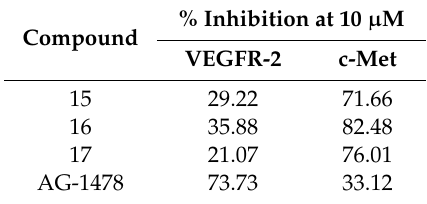
Table 6. Inhibition percent of compounds 15 , 16 and 17 for VEGFR-2 / c-Met kinases. % Inhibition at 10 µ Compound